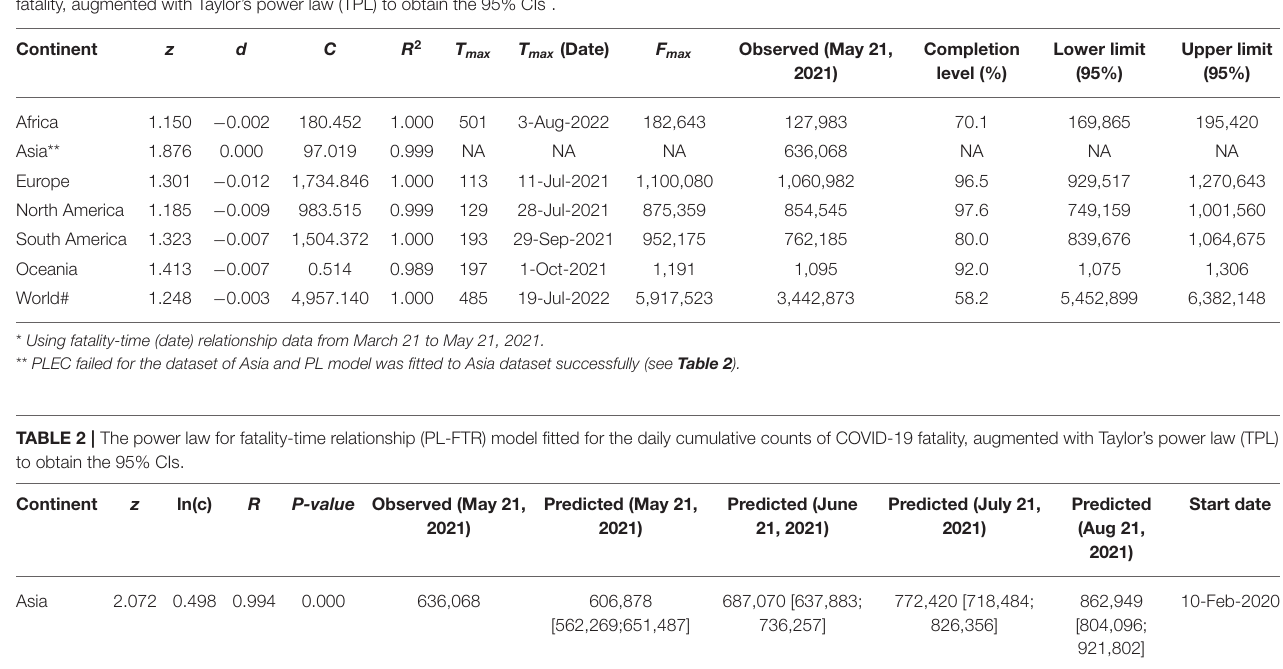
TABLE 1 | The power law with exponential cutoff for fatality-time relationship (PLEC-FTR) model fitted with nonlinear optimization for daily cumulative counts of COVID-19 fatality, augmented with Taylor’s power law (TPL) to obtain the 95% CIs * . Continent z d C R 2 T max T max (Date) F max Observed (May 21, Africa